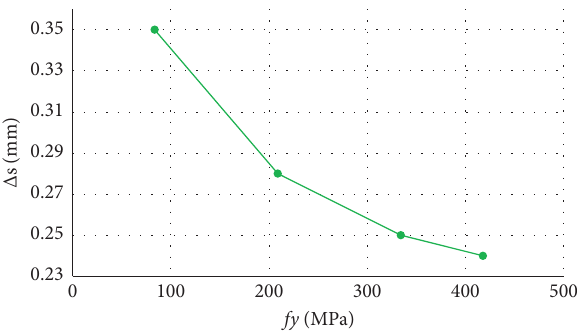
Figure 14: Te maximum slippage-bond strength of the ring contact element.